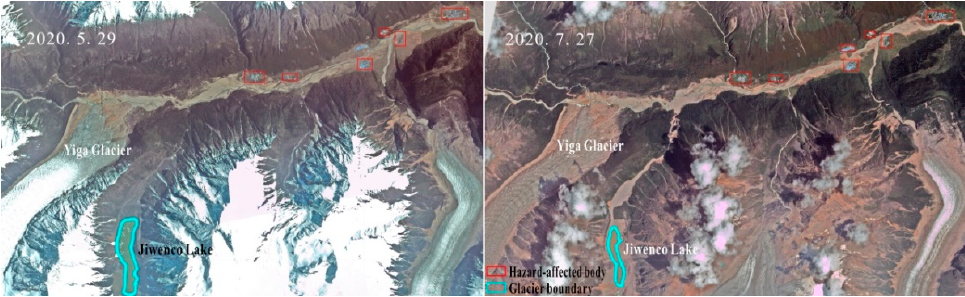
Figure 8. Nidu river change and distribution of hazard-affected bodies before and after the Jiwenco glacier lake outburst.